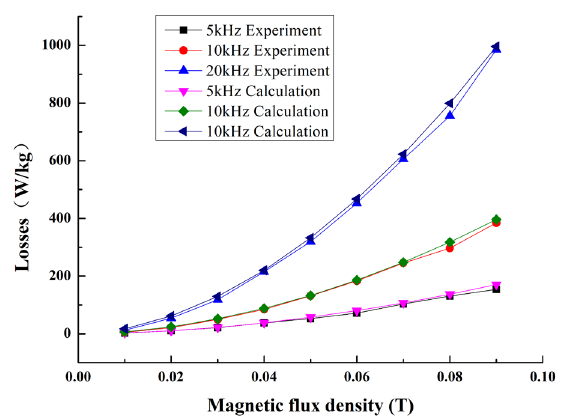
Figure 4. Experiment and calculation of energy losses (5 kHz, 10 kHz and 20 kHz).